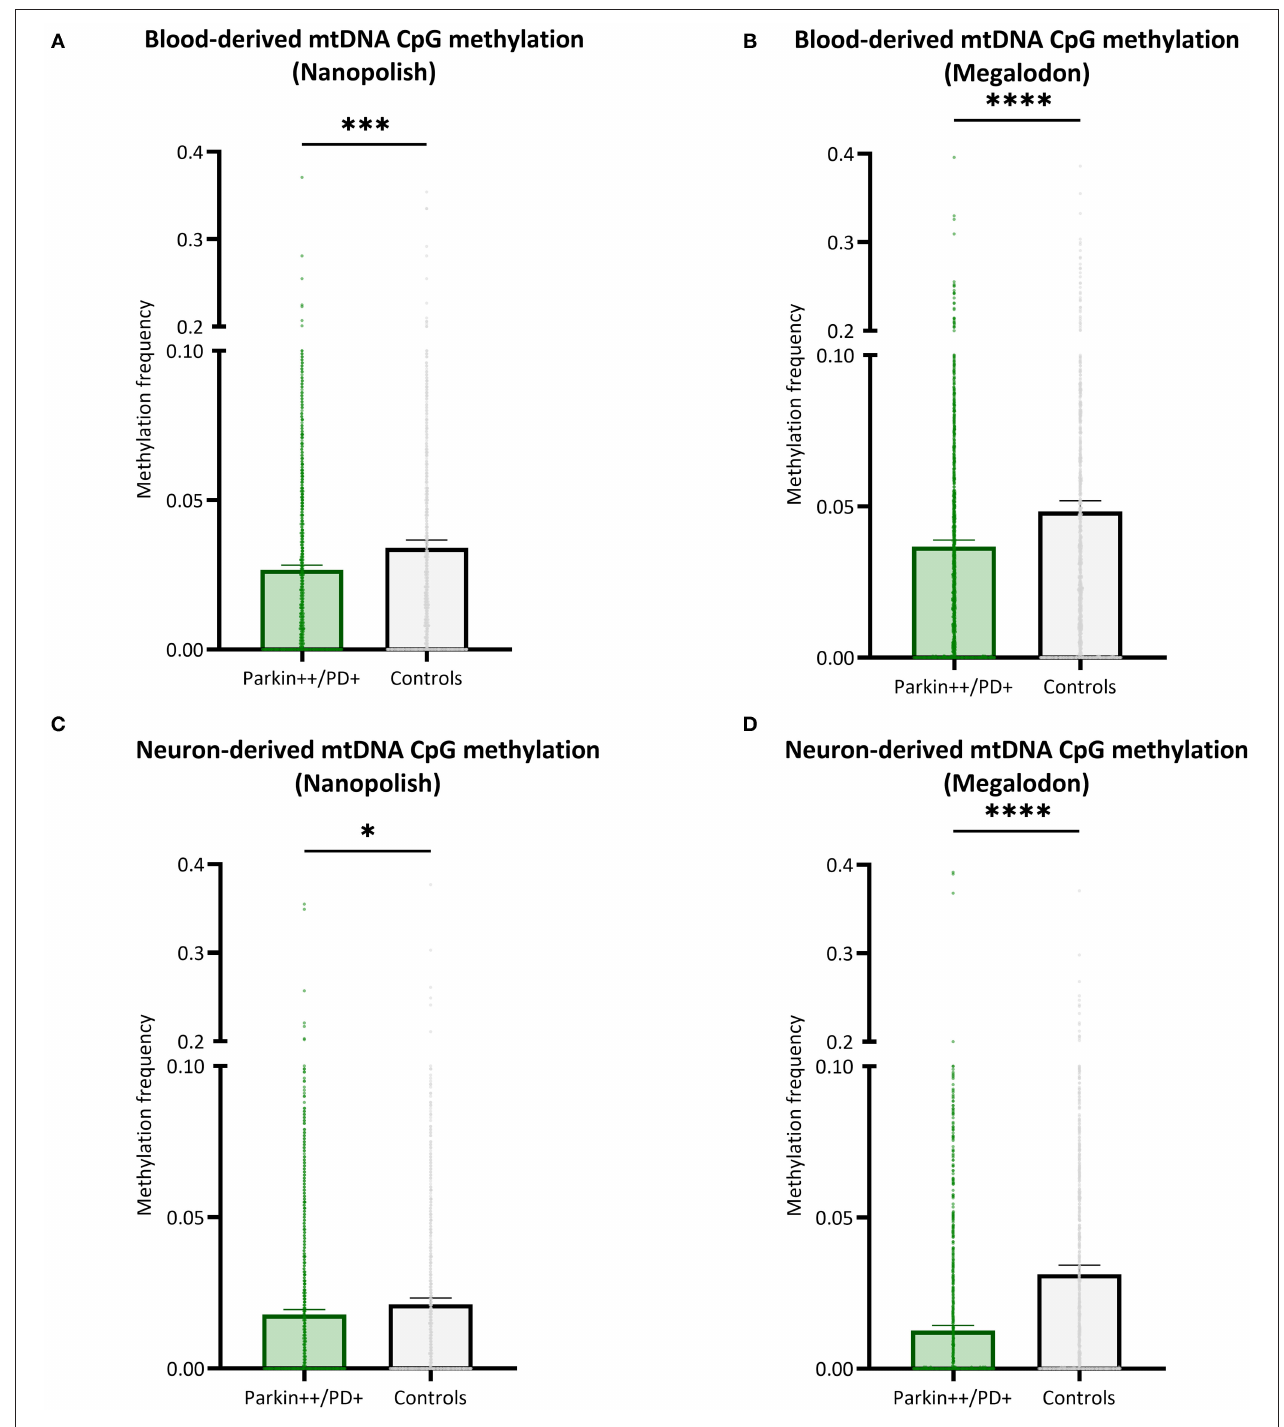
FIGURE 6 | Comparison of mtDNA CpG methylation between patients with Parkin-PD and healthy controls. (A,B) The bar plot shows the mtDNA CpG methylation from blood-derived DNA in patients with Parkin-PD and healthy control subjects, which was either detected with Nanopolish (A) or Megalodon (B) . (C,D) The bar plot shows the mtDNA CpG methylation from neuron-derived DNA (iPSC-derived midbrain neurons) in patients with Parkin-PD and healthy control subjects, which was either detected with Nanopolish (A) or Megalodon (B) . Bars indicate means and 95% confidence interval. The asterisks represent the level of significance (* p ≤ 0.05, ** p ≤ 0.01, *** p ≤ 0.001, **** p ≤ 0.0001), p -value = Mann Whitney U- test performed for pairwise comparisons, Parkin ++ = Parkin biallelic; PD + = PD patient, patients are indicated in green and control subjects in